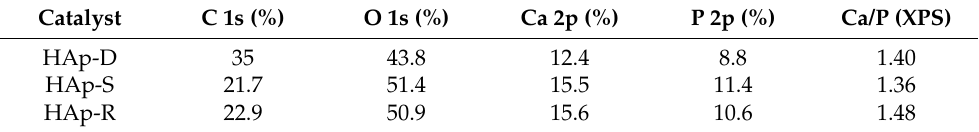
Table 3. Surface chemical compositions (atomic %) of HAp-D, HAp-S, and HAp-R by XPS analysis.